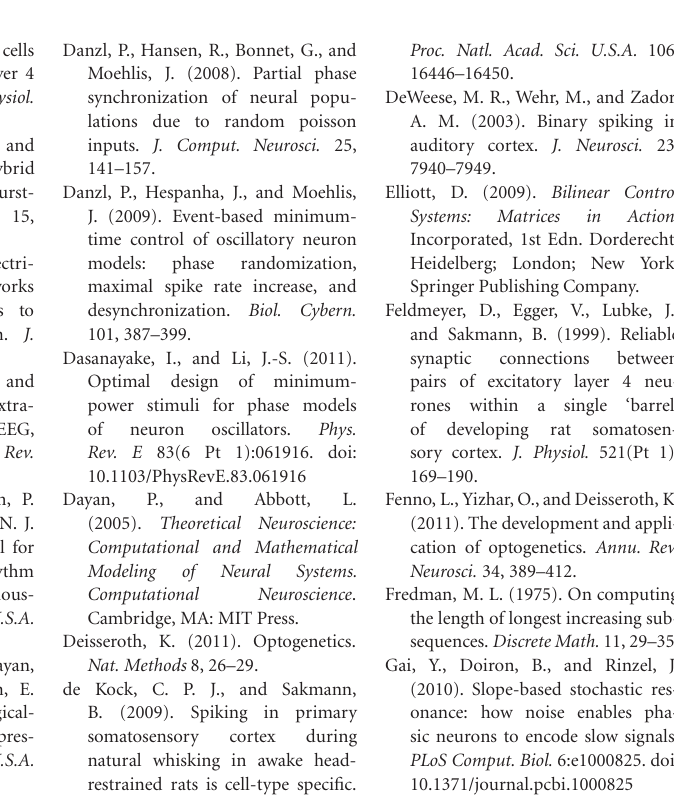
Figure 6 was created by generating random realizations of cell ensembles of variable size. From each ensemble, a control- lable set was realized as above. A superset of 1000 cells was then generated and the percentage of cells that produced col- lateral spikes in that superset was computed for each controlled cell. The average over all controlled cells is then computed. We report this average for 100 realizations of each controlled set